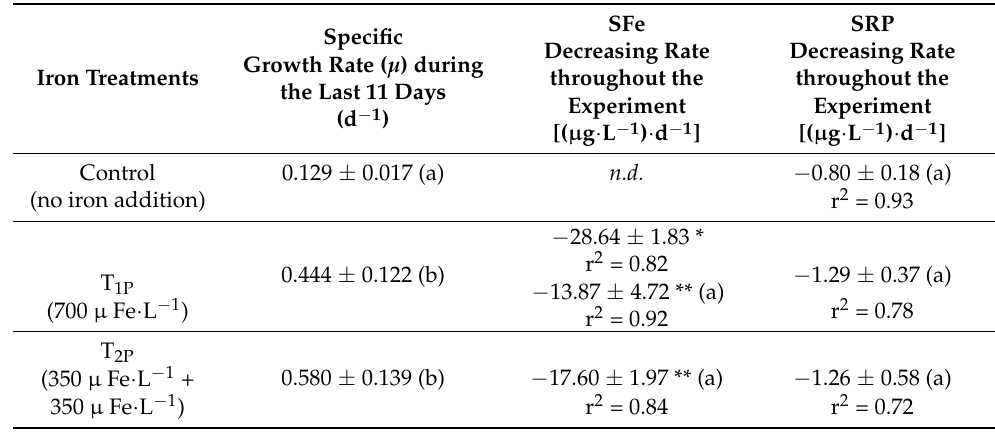
Table 4. Microcystis spp. natural samples collected from the 2018 bloom: specific growth and soluble iron decreasing rates in microcosms exposed to different iron treatments: control, without iron addition; with different iron addition treatments: T 1P , one pulse of 700 µ g · L − 1 ; T 2P , two pulses of 350 µ g · L − 1 each. The mean and standard deviation of growth and decreasing rate values resulted from triplicate microcosms. Different letters indicate significant differences among treatments. SFe: soluble iron; SRP: soluble reactive phosphorus; n.d. : not detectable. Period considered: * D1–D25;